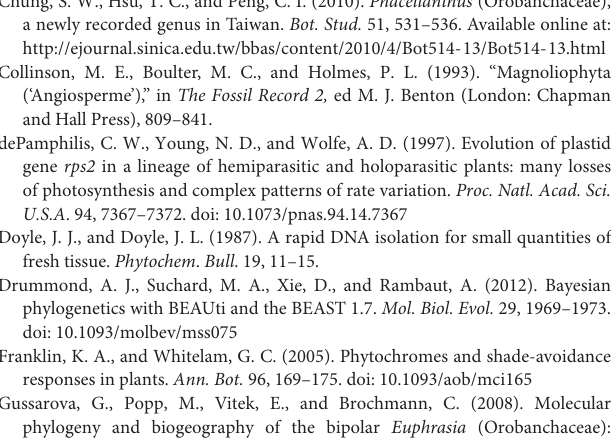
Figure S5 | Phylogenetic tree of Orobanchaceae including Gleadovia mupinensis and Phacellanthus tubiflorus based on PHYA data with ML method. Figure S6 | Phylogenetic tree of Orobanchaceae including Gleadovia mupinensis and Phacellanthus tubiflorus based on PHYB data with ML method. Figure S7 | Expanded phylogenetic trees based on ITS sequences for Orobanche with ML method. Figure S8 | Expanded phylogenetic trees based on ITS sequences for Orobanchaceae with ML method. Figure S9 | Expanded phylogenetic trees based on rps2 sequences for Orobanche with ML method. Figure S10 | Expanded phylogenetic trees based on rps2 sequences for Orobanchaceae with ML method. Figure S11 | Expanded maximum likelihood phylogenetic tree of Orobanchaceae inferred from the combined five-gene data set ( PHYA , PHYB , ITS, mat K, and rps2 ) partitioned by gene. Figure S12 | Maximum likelihood phylogenetic tree of Orobanchaceae inferred from the combined five-gene data set ( PHYA , PHYB , ITS, mat K, and rps2 ) partitioned by codon. Figure S13 | Bayesian phylogenetic tree of Orobanchaceae inferred from the combined five-gene data set ( PHYA , PHYB , ITS, mat K, and rps2 ) partitioned by gene. Figure S14 | Bayesian phylogenetic tree of Orobanchaceae inferred from the combined five-gene data set ( PHYA , PHYB , ITS, mat K, and rps2 ) partitioned by codon. Figure S15 | Divergence time estimation of Orobanchaceae using combined five-gene data obtained from BEAST analysis. Table S1 | The primer information for PCR amplification and cycle sequencing. Table S2 | PCR amplification programs of each gene used in this study. Table S3 | GenBank accession numbers for species used in this study. Table S4 | Summarized results of maximum likelihood analyses in Orobanchaceae based on single gene and combined mat K and rps2 (plastid) data partitioned by gene. Table S5 | Summarized results of maximum likelihood analyses in Orobanchaceae based on single gene and combined mat K and rps2 (plastid) data partitioned by